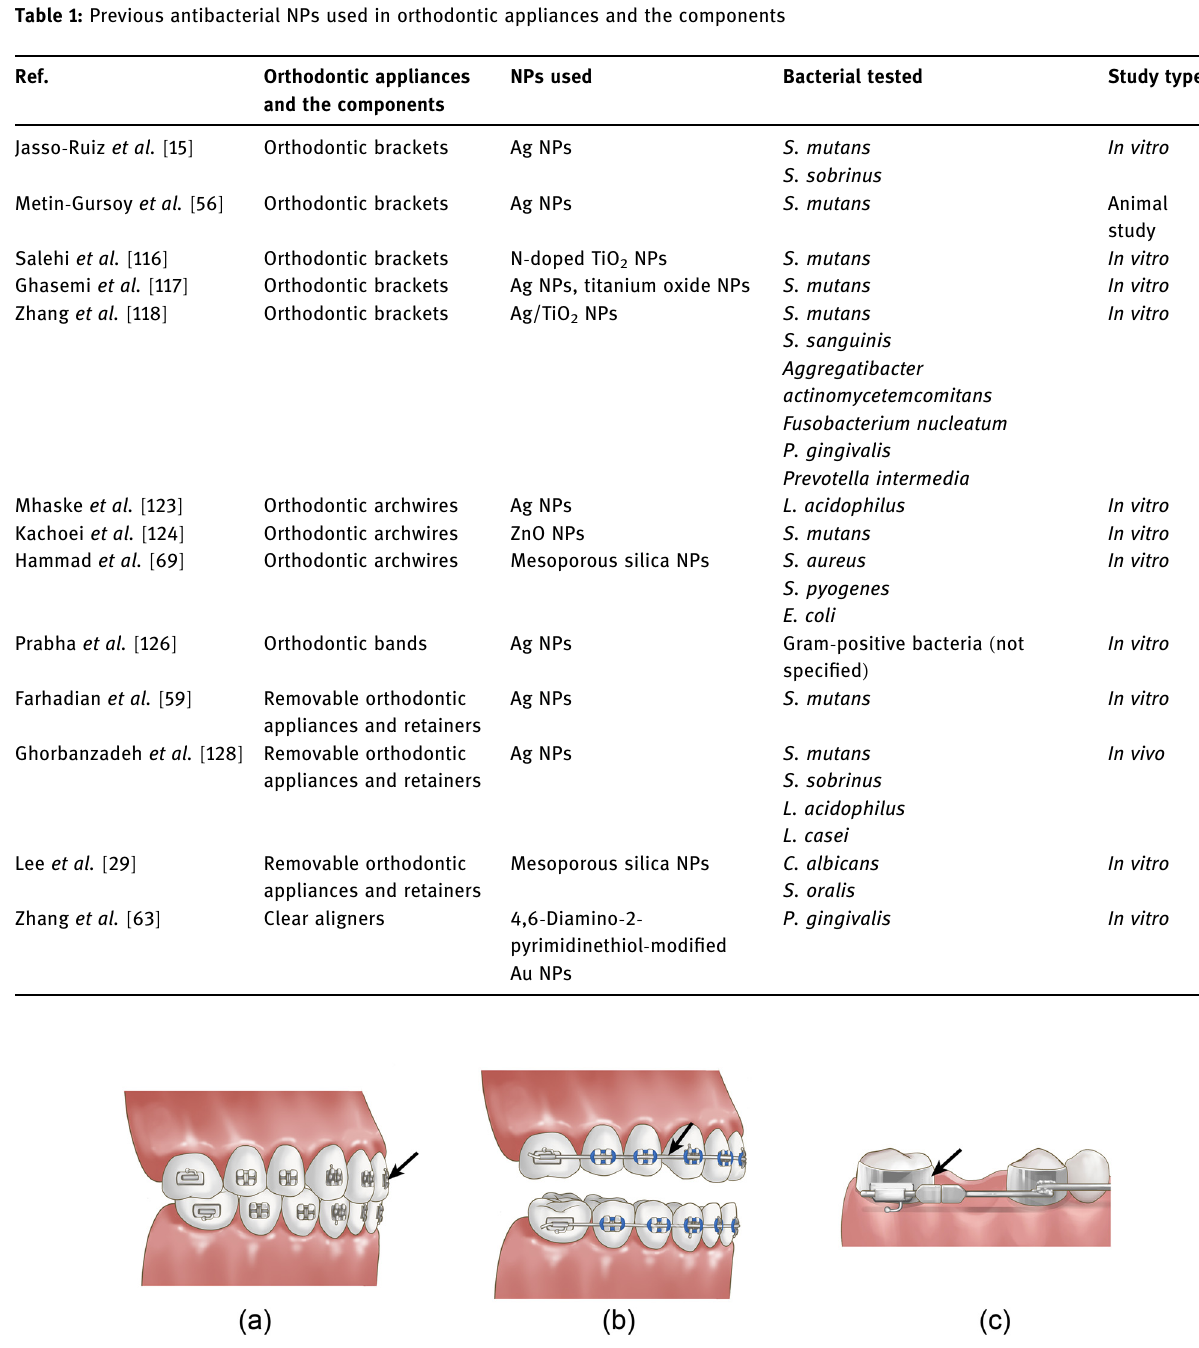
Figure 2: ( a ) Orthodontic stainless - steel brackets; ( b ) orthodontic metal archwires; and ( c ) orthodontic stainless - steel bands ( black arrow points )